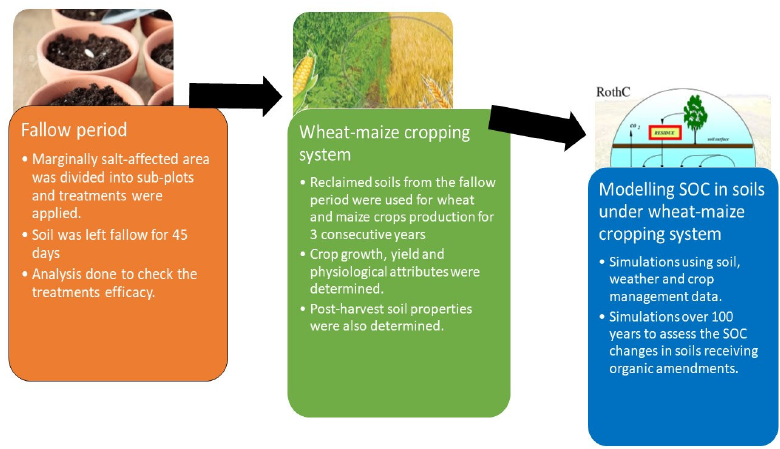
Figure 2. Overview of the study. Note: SOC = soil organic